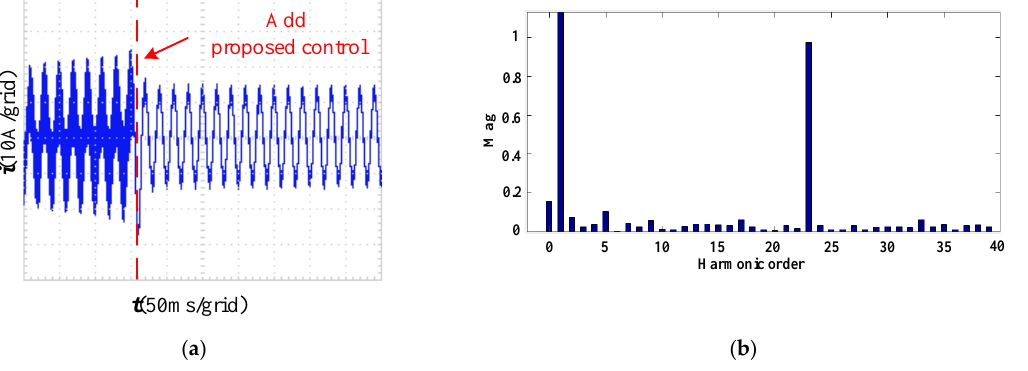
Figure 28. The HCGI output current with 23th order harmonic current. ( a ) Output current; ( b ) THD analysis (fundamental component =9.734 A, 23th current component = 0.925 A, THD = 12.07%).